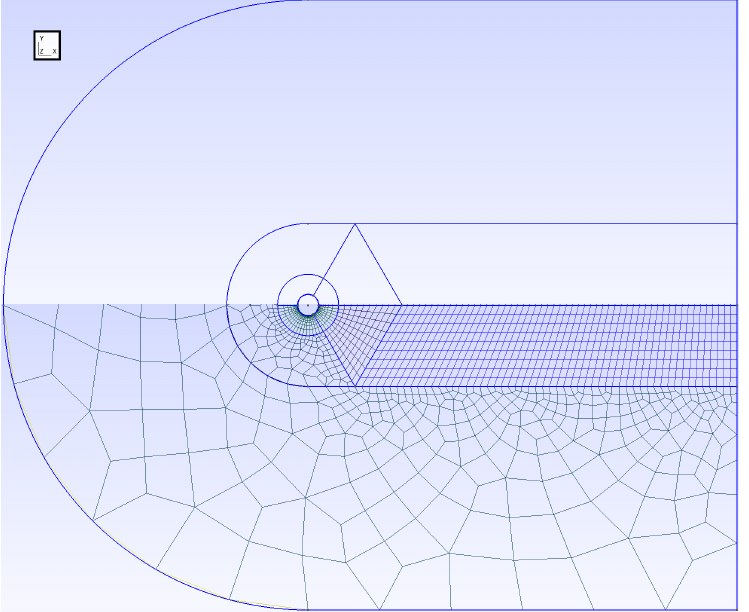
Figure 3. Two-dimensional mesh. It is worth noting that this mesh has not yet received p-type refinement ( N p = 2), that is, in this case, in each direction the elements still will be “divided” in half, then increasing its